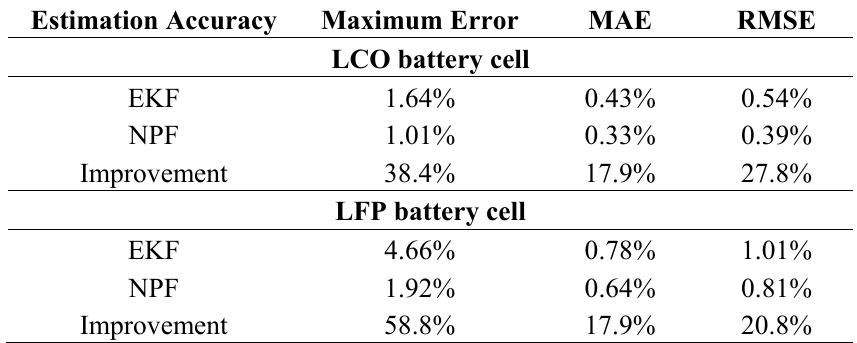
Figure 15. Comparison results of SOC estimation for LFP battery cell with accurate initial SOC: ( a ) SOC estimation; ( b ) Error of SOC estimation; ( c ) MAE of SOC estimation; ( d ) RMSE of SOC estimation. Table 5. Comparison results of estimation